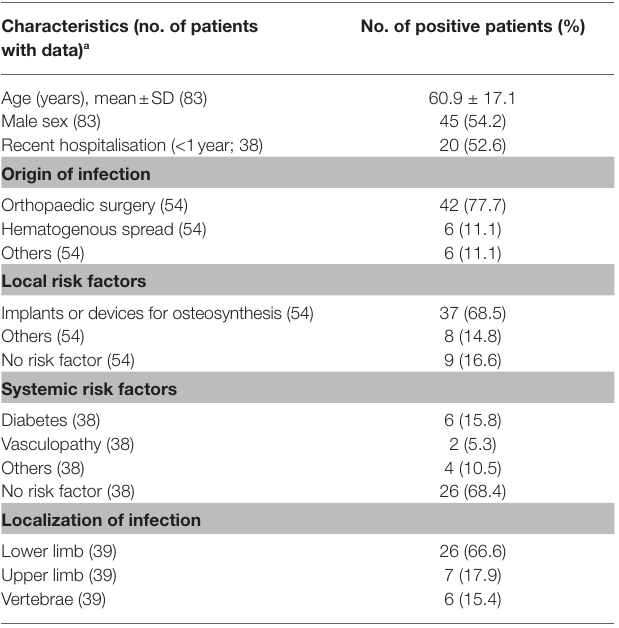
No. of positive patients